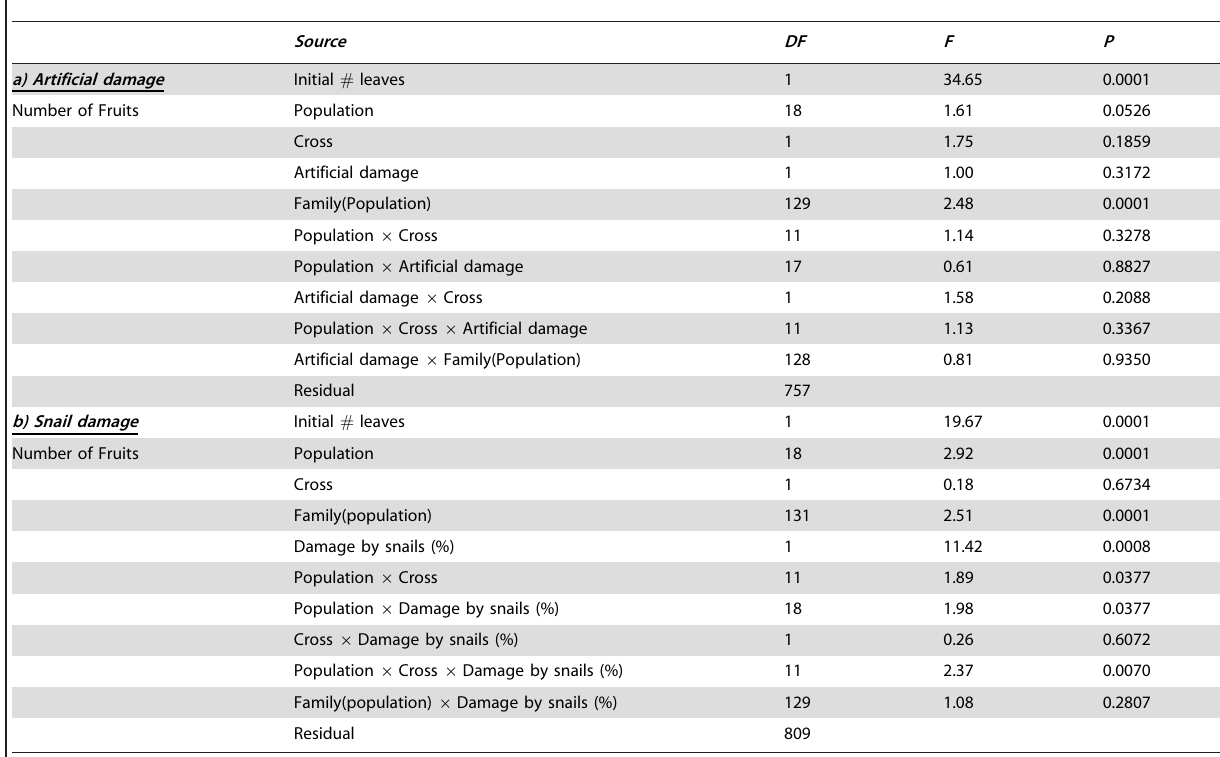
Table 2. Outbreeding effects on tolerance to snail and artificial